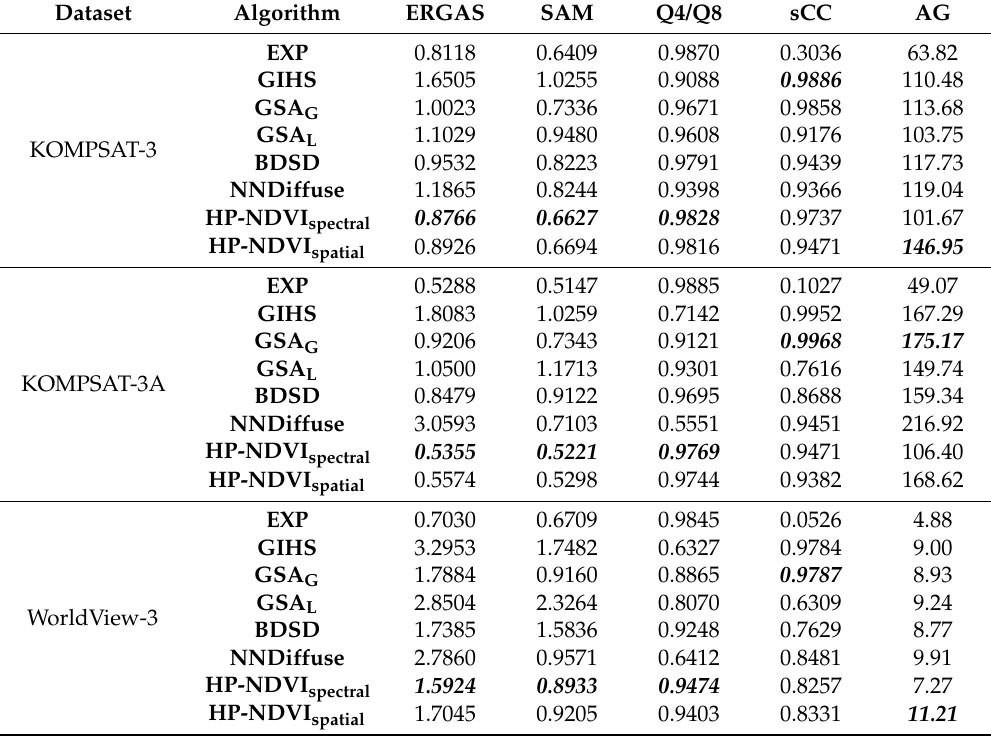
Table 3. Comparative pansharpening result corresponding to each satellite sensor. ERGAS: erreur relative globale adimensionnelle de synth è se; SAM, the spectral angle mapper; sCC, spatial correlation coefficient; AG, average gradient; EXP : expanded multispectral image; GIHS : generalized